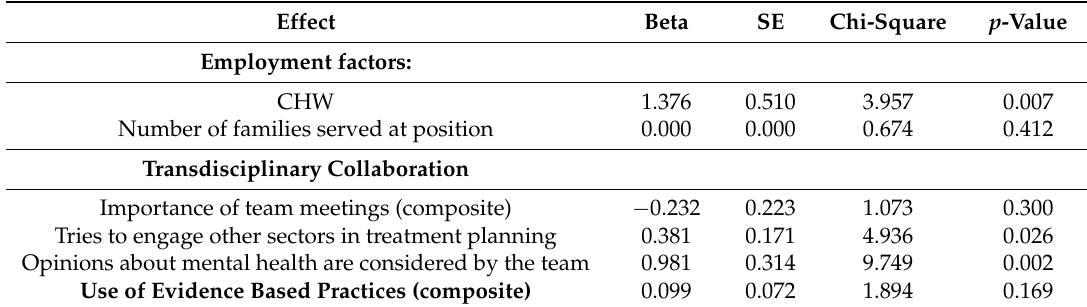
Table 2. Logistic regression reporting factors associated with providers’ perceptions of patient-centered mental health care provision ( n =